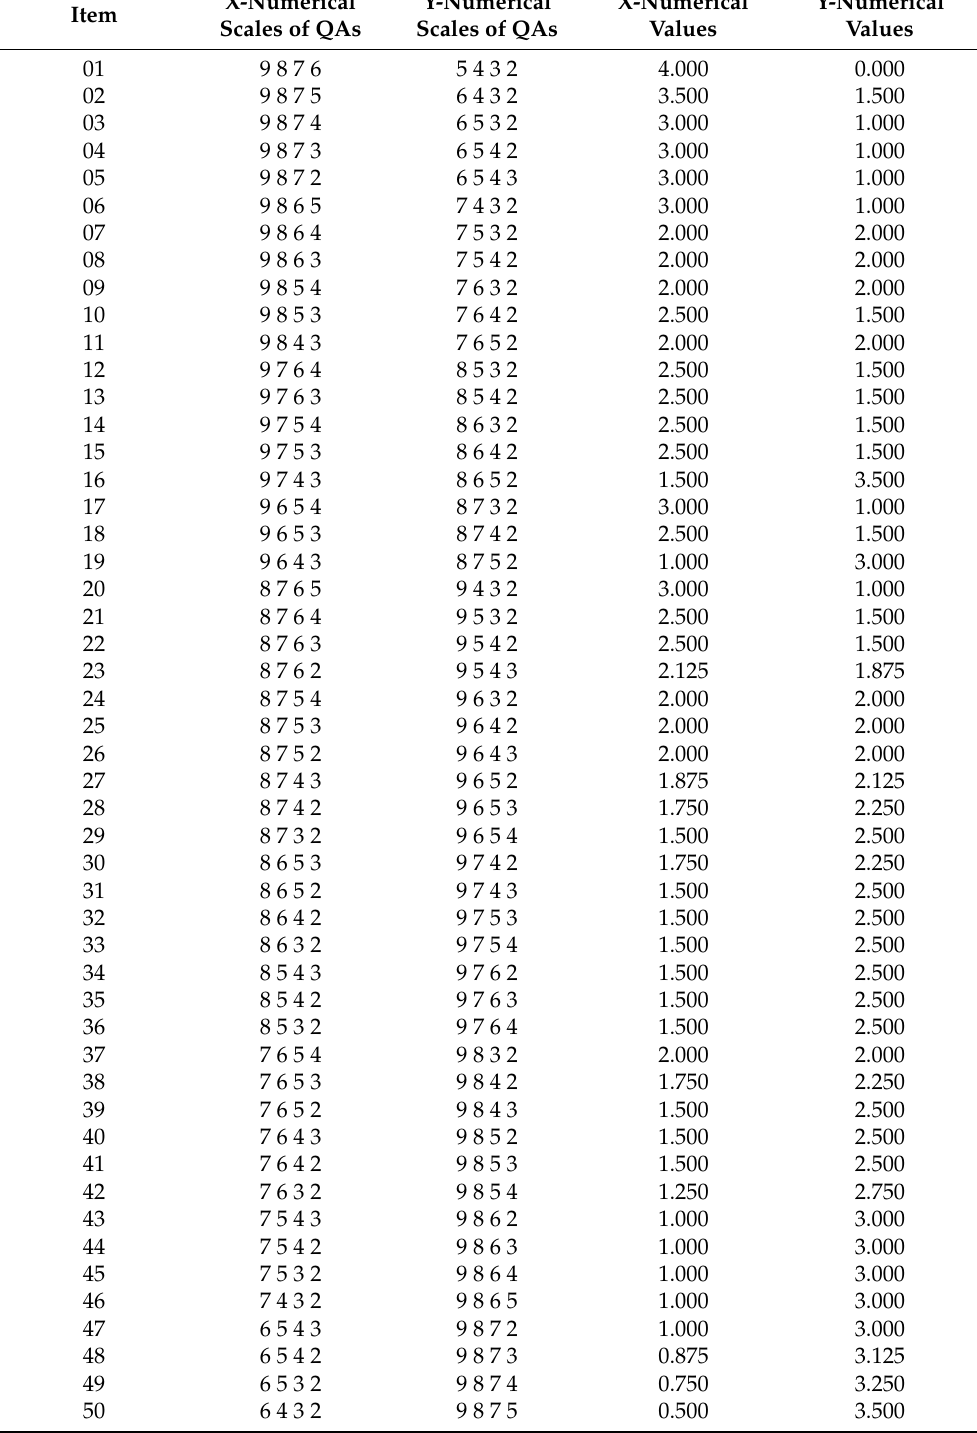
Table 4. Four QAs numerical scales modelling with M numerical